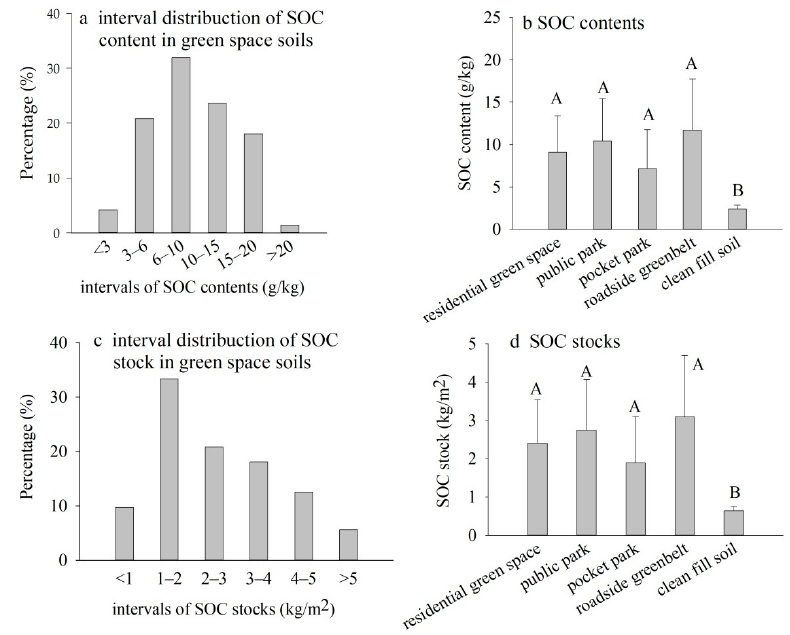
Figure 2. Interval distributions of SOC contents ( a ) and SOC stocks ( c ) across green space types; SOC contents ( b ) and SOC stocks ( d ) across land covers. Different letters denote significant differences among green space types at p < 0.05. Table 1. SOC content and stock in different green space types (mean ± SE).